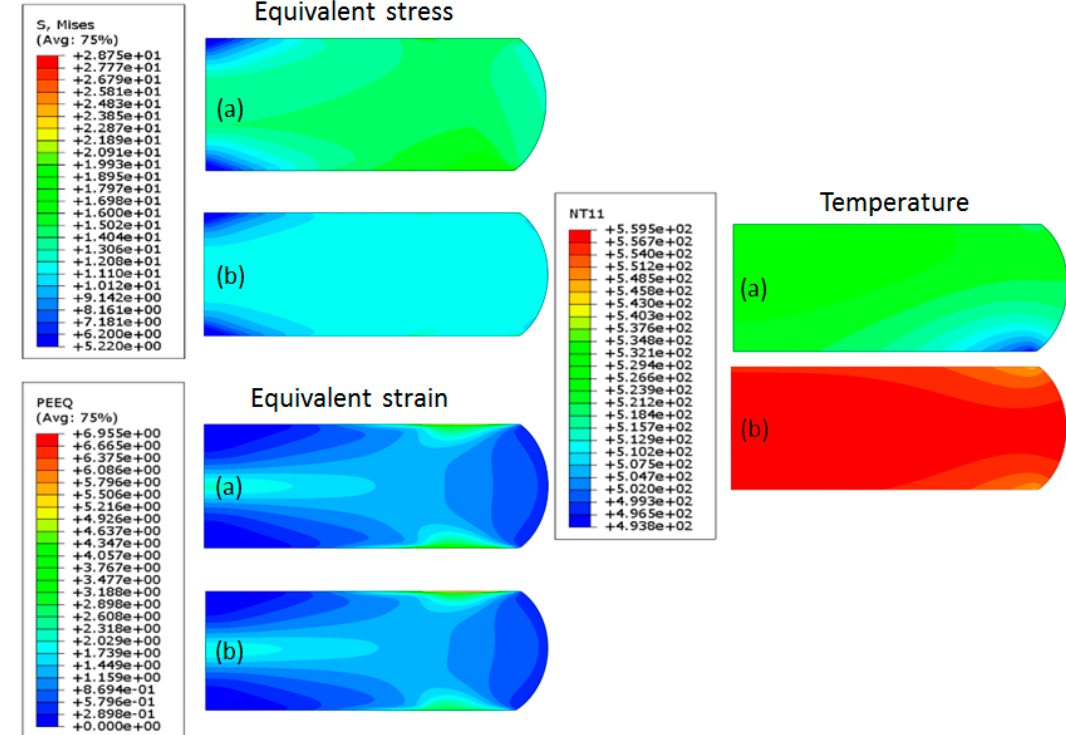
Figure 4. Thermo-mechanical fields (equivalent stress, equivalent strain, and temperature) for the upsetting conditions of specimen A7 as obtained from: ( a ) a thermo-mechanical model, including calculation of the pre-upsetting system preparation; ( b ) a thermo-mechanical model without preparation (constant initial temperatures).